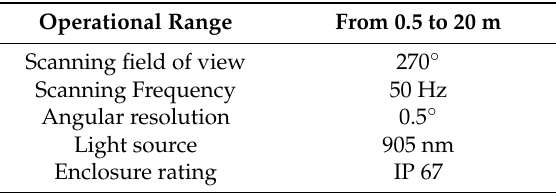
Figure 1. Details of the sensors on the laboratory platform (vertical LiDAR and Light-beam sensors) for the detection and structure of the modular 3D plant. Table 2. LMS 111 technical data.